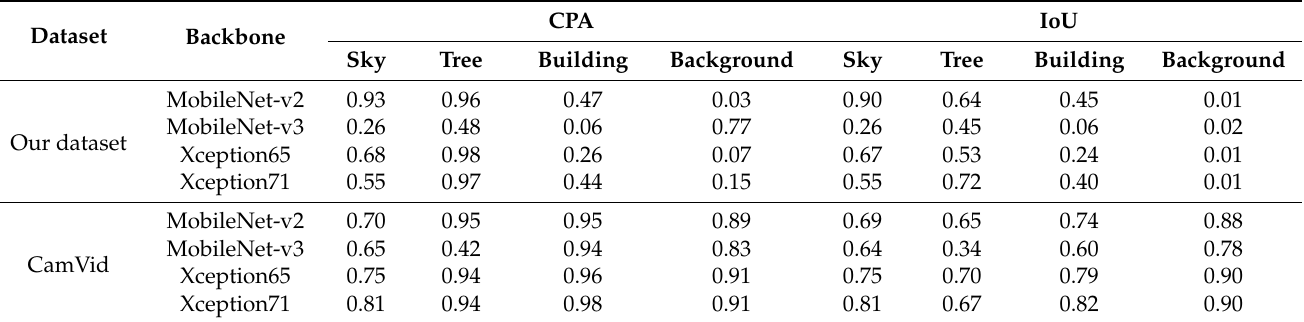
Table 1. Performance of the DeepLabv3+ model for deep feature migration. Except for the sky, tree and building categories, other categories are defined as